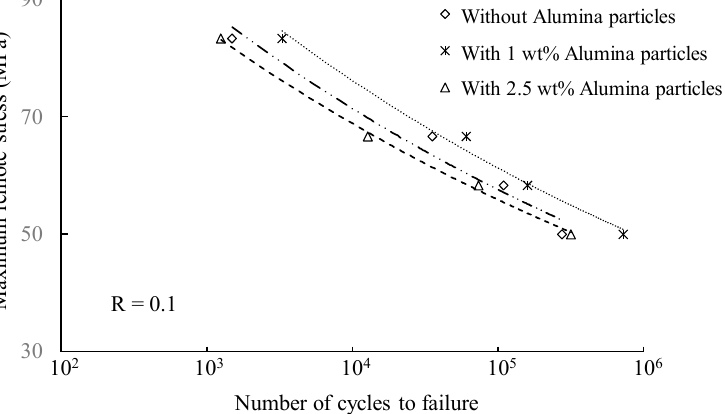
Figure 14. S–N curves of alloyed FSW samples with copper foil in the SZ and their comparison with that of as-welded samples.